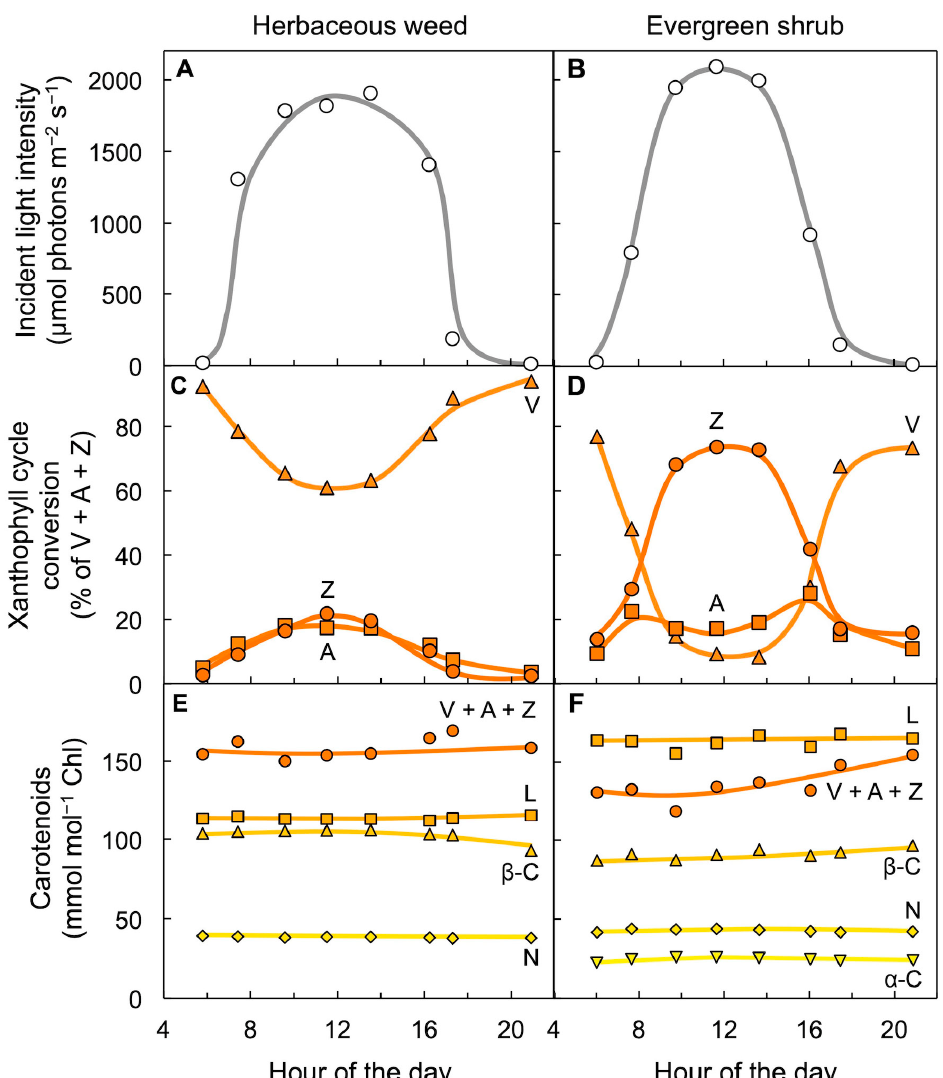
Figure 4. Diurnal characterization of foliar carotenoid content for leaves of an herbaceous, biennial weed ( Malva neglecta ) that tracks the sun and a woody, evergreen shrub ( Euonymus kiautschovicus ) on a sunny day (15 September 1990). ( A , B ) Direct sunlight incident on the upper leaf surface, ( C , D ) conversion state of the xanthophyll cycle with each component (V = violaxanthin, Z = zeaxanthin, and A = antheraxanthin) expressed as percent of total xanthophyll cycle pool (V + A + Z), and ( E , F ) levels of α -carotene ( α -C), neoxanthin (N), β -carotene ( β -C), lutein (L), and total xanthophyll cycle pool (V + A + Z) relative to chlorophyll (Chl). Data are from Adams and Demmig-Adams [33].